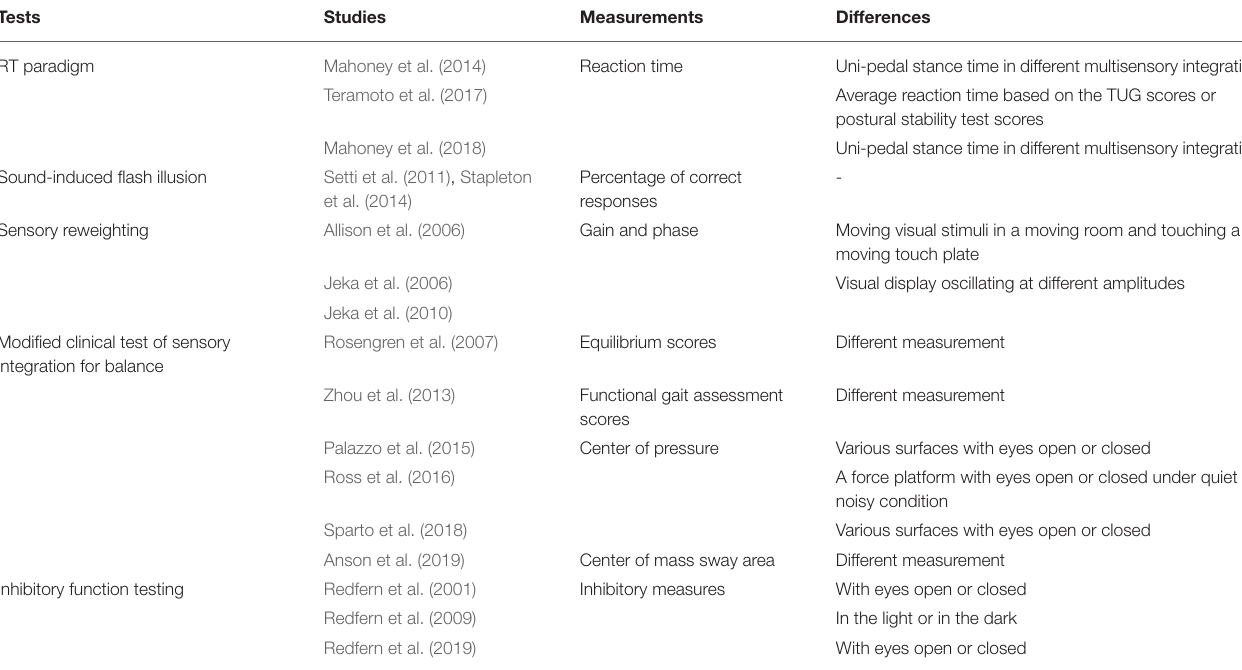
TABLE 5 | Studies grouped in terms of tests